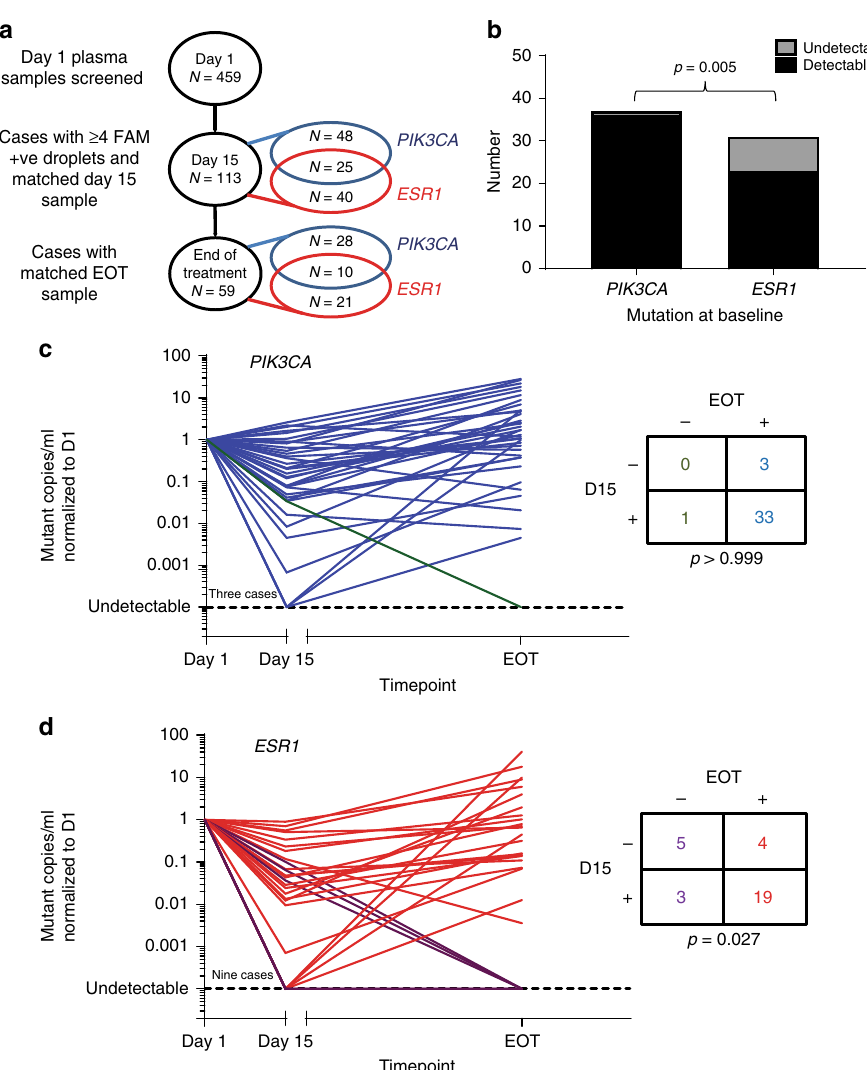
Fig. 5 Clonal composition at relapse is anticipated by early ctDNA dynamics. a Samples with PIK3CA and ESR1 mutations used in longitudinal clonal analysis. b Comparison of PIK3CA mutation and ESR1 mutation detection at end of treatment. p value two sample t test. c Spider plot for 37 patients with PIK3CA mutation in longitudinal clonality analysis. Mutant copies/ml normalized to day 1. Lines are colored as for the accompanying contingency table, patients with detectable end of treatment mutation colored blue and undetectable colored green. p value Fisher ’ s exact test. d Spider plot for 31 patients with ESR1 mutation in longitudinal clonality analysis. Mutant copies/ml are normalized to the value at day 1. Lines are colored as for the accompanying contingency table, patients with detectable end of treatment mutation colored red and undetectable colored purple. p value Fisher ’ s exact